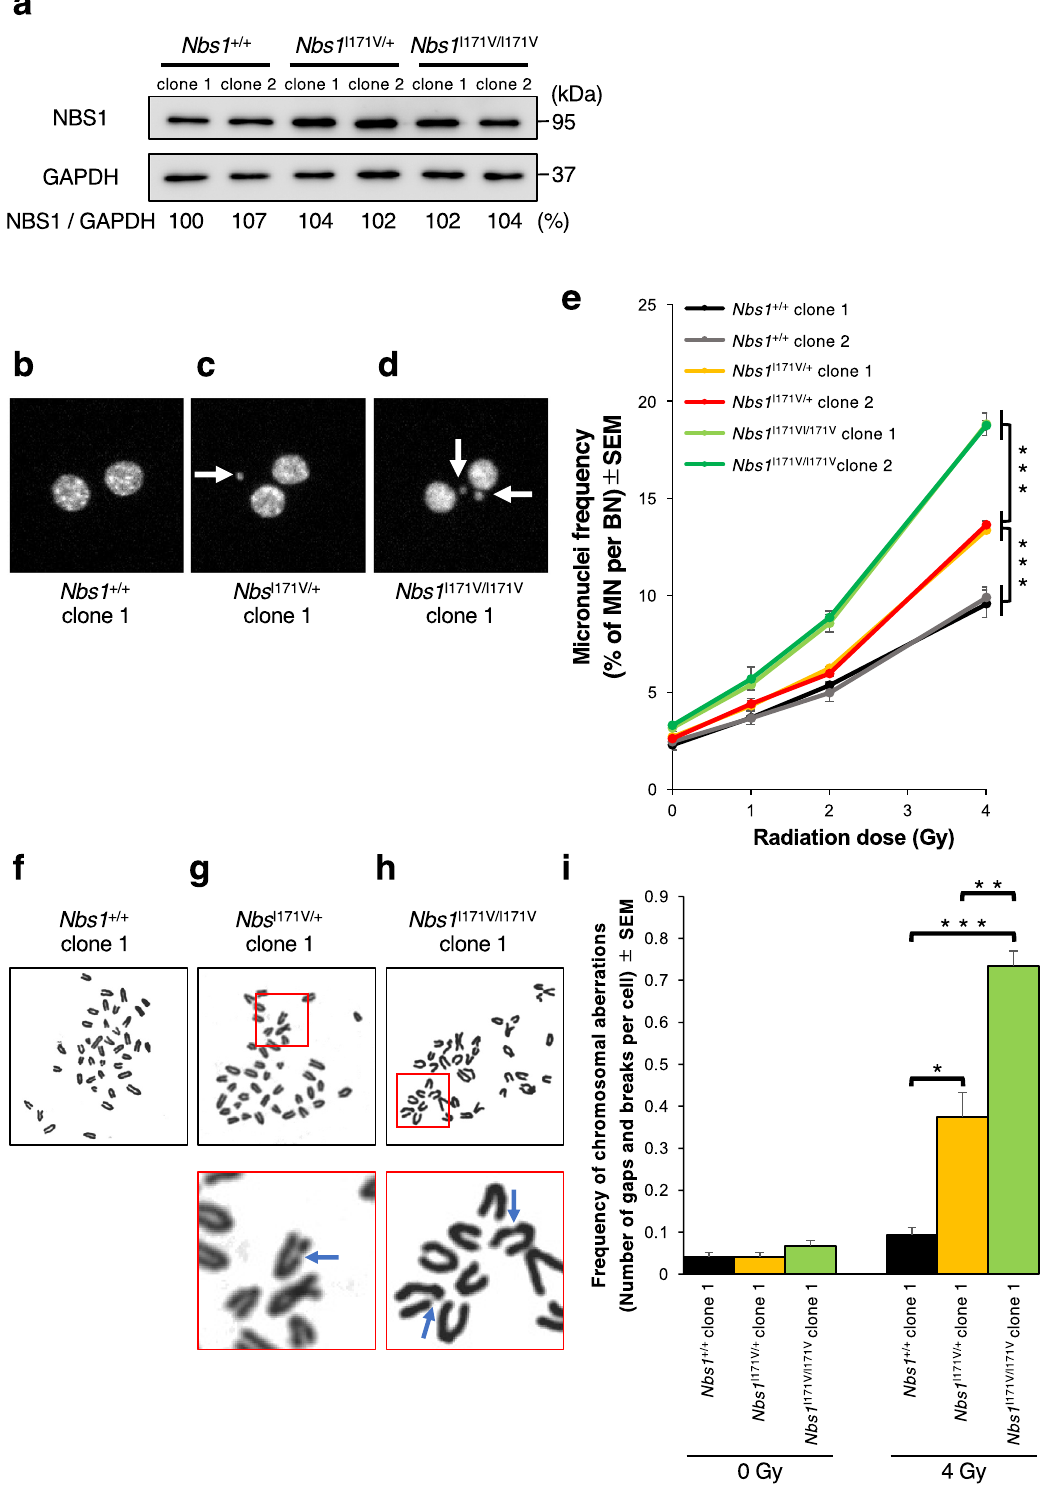
Figure 3. Radiation-induced chromosomal instability of Nbs1 I171V edited MEF clones. ( a ) Western blotting analysis data showing the expression levels of Nbs1 protein in Nbs1 I171V edited MEF clones. Full-length gel is presented in Supplementary Fig. 5. The GAPDH antibody was used as a loading control. The intensity of Nbs1 bands was normalized to that of GAPDH and shown as a percentage, regarding the score of Nbs1 +/+ clone 1 as 100%. ( b – d ) Metafer MN Search images showing the cytokinesis-blocked Nbs1 I171V edited MEFs stained with DAPI. Arrowheads indicate MN. Nbs1 +/+ -BN cell without MN ( b ), Nbs1 I171V/+ -BN cell with one MN ( c ), Nbs1 I171V/I171V -BN cell with three MN ( d ). ( e ) Percentage of IR-induced MN formation in Nbs1 I171V edited MEF clones (mean ± SEM; t -test; n = 3; > 1000 BN cells). ( f, g ) Representative metaphase of Nbs1 I171V-edited MEFs after 4 Gy irradiation. Remarkable aberrations are enlarged. Arrows indicate chromosomal breakages. ( i ) Frequency of IR-induced chromosomal aberrations in Nbs1 I171V edited MEF clones (mean ± SEM; t -test; n = 3; > 50